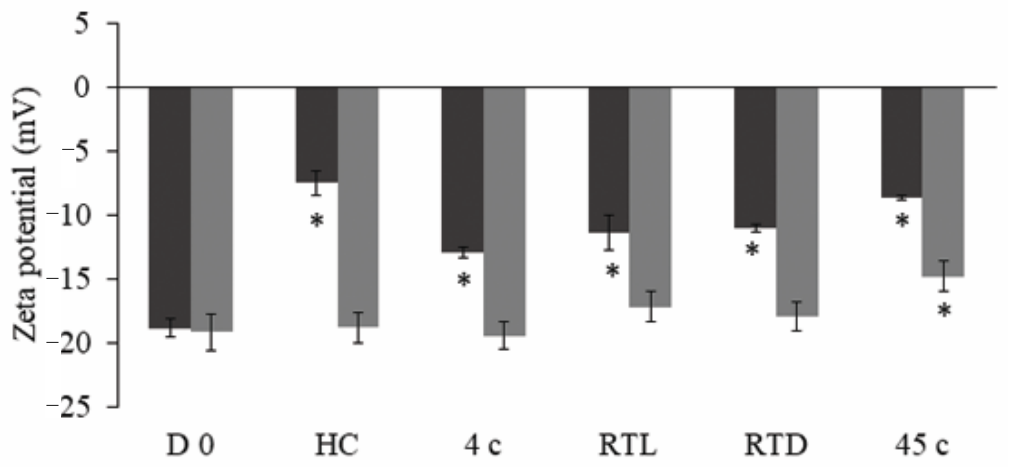
Figure 3. Mean droplet size and mean polydispersity index ( PDI ) of ( ) N1 - EF and ( ) N2 - EF at the starting point ( D 0 ) and after storage in various conditions including heating - cooling ( HC ) for six cycles, 4 °C, room temperature with light ( RTL ) , room temperature without light ( RTD ) and 45 °C for 90 d ( mean ± SD; n = 3 ) , * indicates a significant difference ( p < 0 . 05 ) from D 0 of each formulation .